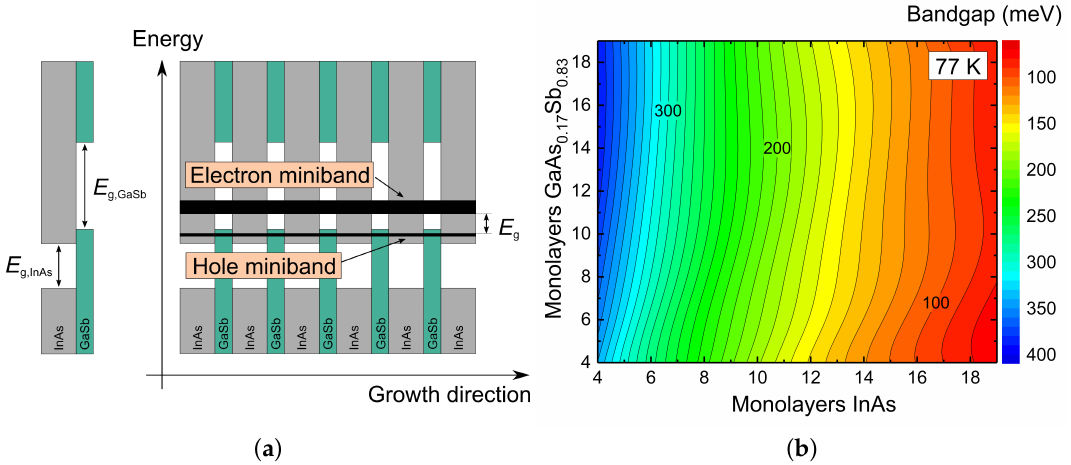
Figure 1. ( a ) Schematic of the type-IIb band alignment between InAs and GaSb and an InAs / GaSb type-II superlattice with lowest electron miniband and highest hole miniband. ( b ) Bandgap energy in dependence of the InAs / GaSb superlattice composition, calculated by the superlattice empirical pseudopotential method